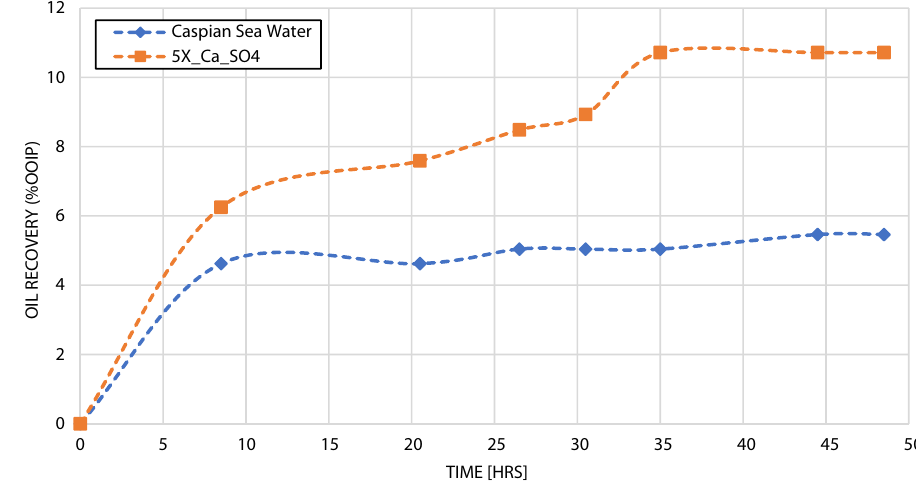
Fig. 11 Recovery factor trends by spontaneous imbibition tests